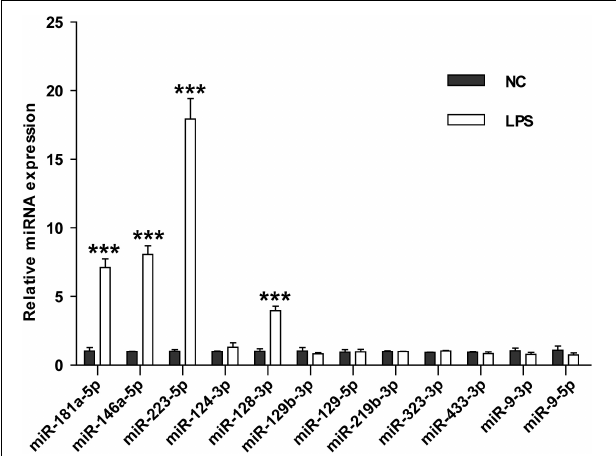
FIGURE 7 | The effects of LPS challenge on the expression of brain-specific miRNAs in the mouse serum sEVs. RT-PCR assessed the expression of nine brain-specific miRNAs and three inflammatory miRNAs in the mouse serum sEVs. Data were expressed as the fold change ± SEM ( n = 3) compared to normal control (NC). Statistical significance was determined by student t -test. *** p < 0.001.